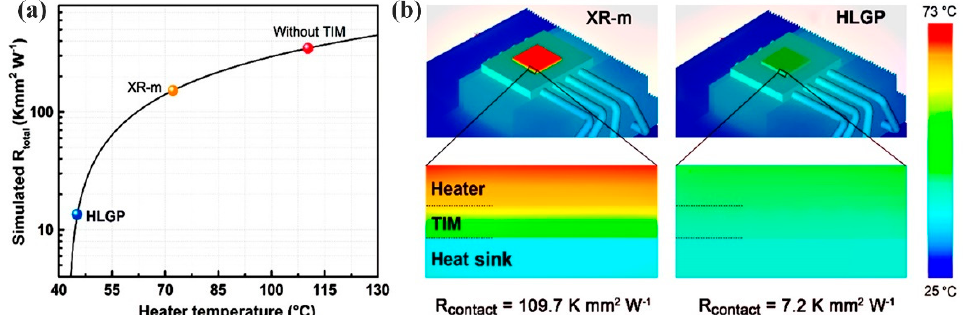
Figure 30. ( a ) Calculated total thermal resistance R total . ( b ) Comparison of heat dissipation capability based on ANSYS Icepak system model (reproduced with permission from [193]).